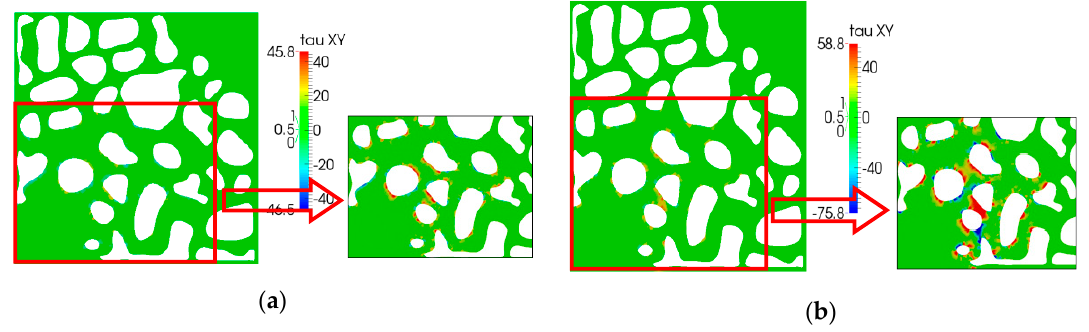
Figure 13. Shear stress ( τ xy ) distribution: ( a ) λ = 0.01 s; ( b ) λ = 0.05 s.